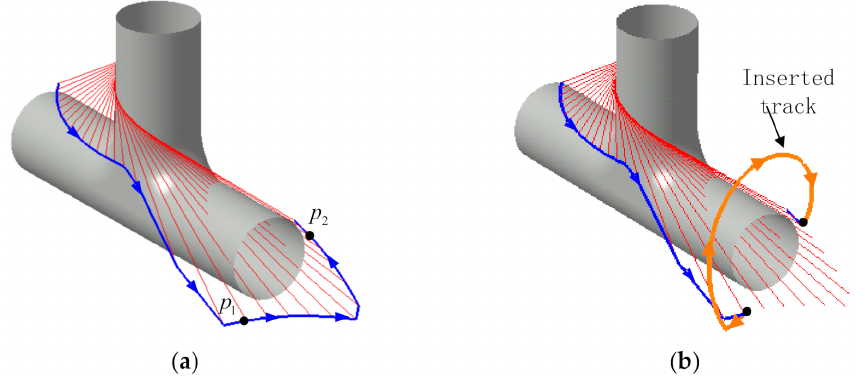
Figure 8. Schematic of the interference and solution: ( a ) Interference diagram; ( b ) Inserted